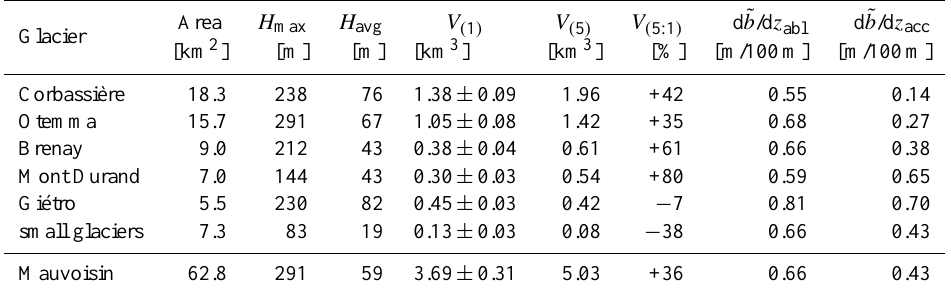
Table 3. Area, maximal ( H max ) and mean ( H avg ) ice thickness, ice volume of (1) ( V ( 1 ) ) and standard deviation, ice volume of (5) ( V ( 5 ) ), the relative ice volume difference between V ( 1 ) and V ( 5 ) ( V ( 5 : 1 ) ), and the calibrated apparent mass balance gradients for the ablation (d ˜ b /d z abl ) and accumulation zone (d ˜ b /d z acc ) of the Mauvoisin region. Glacier